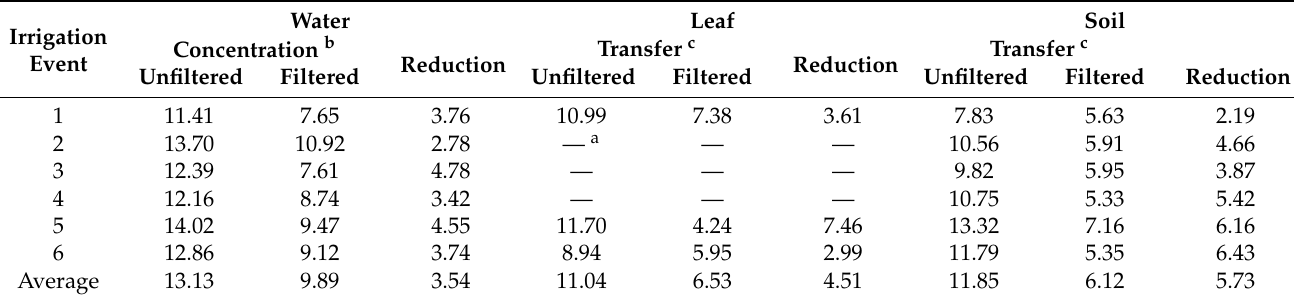
Table 1. Average concentrations (lnMPN/mL) of E. coli TVS 353 in unfiltered and filtered irrigation water, and average transfer to leaf and soil (lnMPN/g) for each irrigation event. Reductions and differences between unfiltered and filtered water for each irrigation event in irrigation water, on leaves, and in soil, with the overall average for all irrigation events, in all